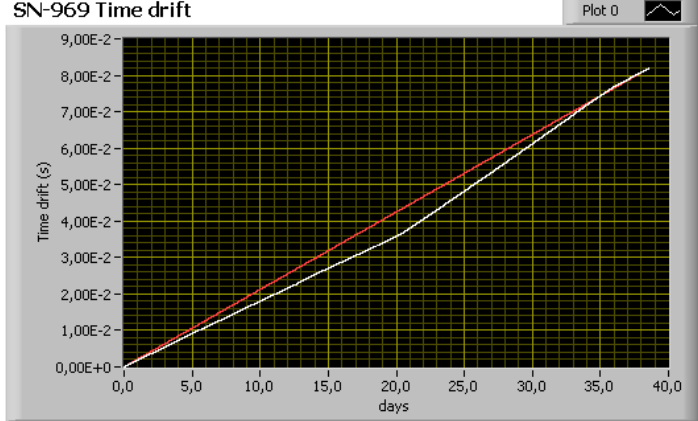
Figure 22. Time drift of the Seascan module (SN-968). The white line is the time drift of the crystal measured. The red line is the time drift correction of the OBS